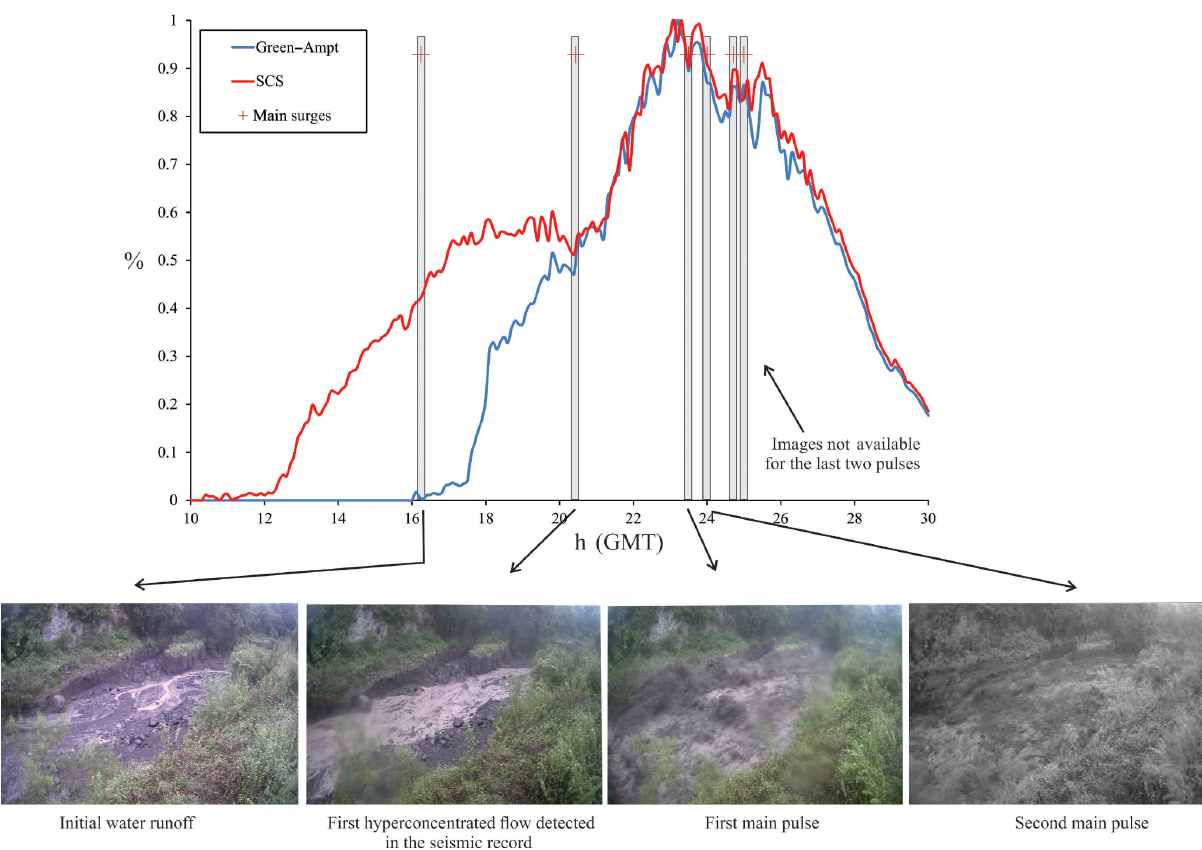
Figure 4. Comparison of simulated watershed discharge curves based on SCS-NC and G–A infiltration models. Qualitative calibration is here proposed based on the flow discharge as observed in the video images captured at the MSL site.